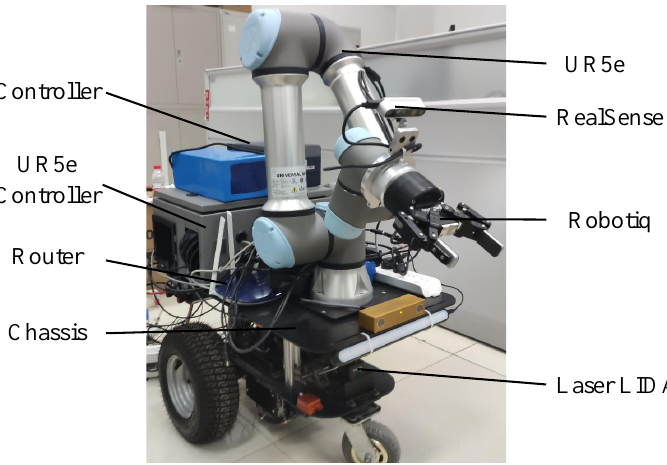
Figure 6. The prototype of the proposed mobile